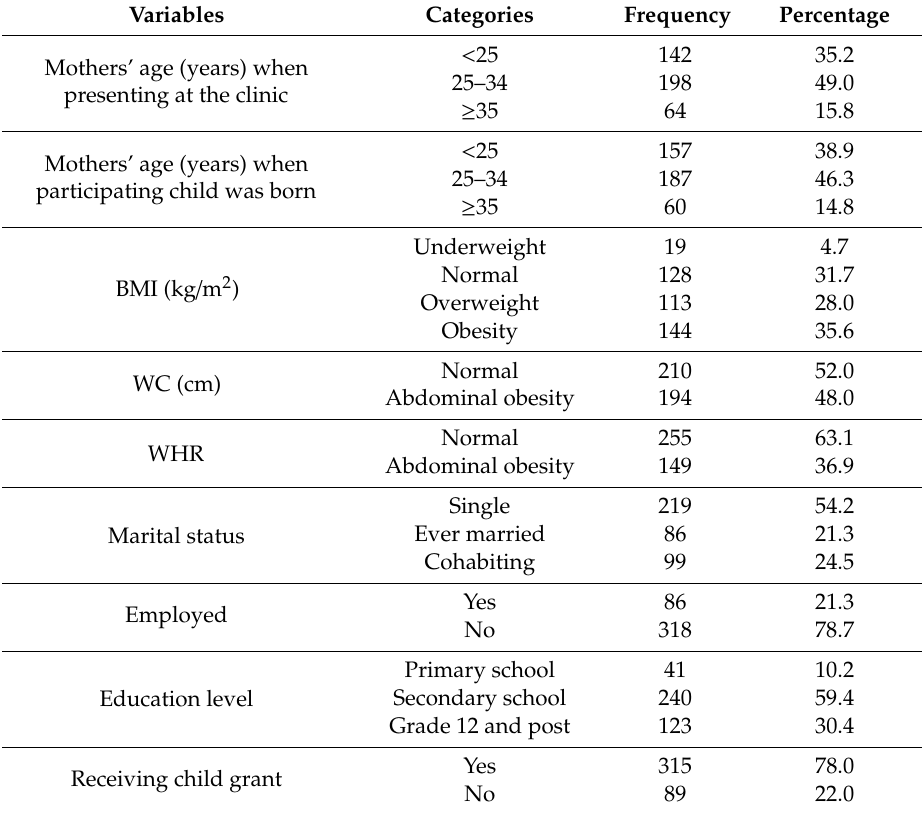
Table 2. Characteristics of mothers of children under five years of